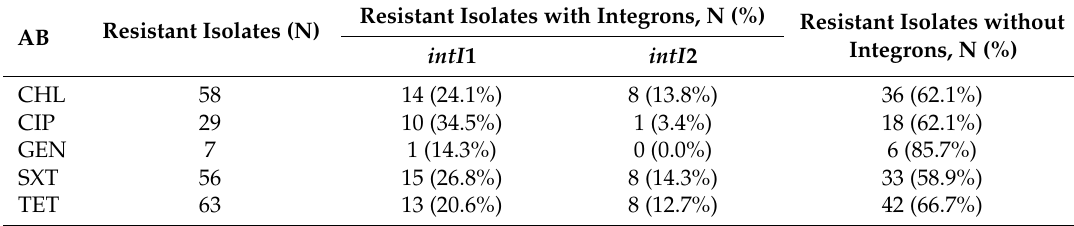
Table 4. Resistance phenotype of isolates from four livestock enterprises to non- β -lactamic AB and corresponding presence of integrons